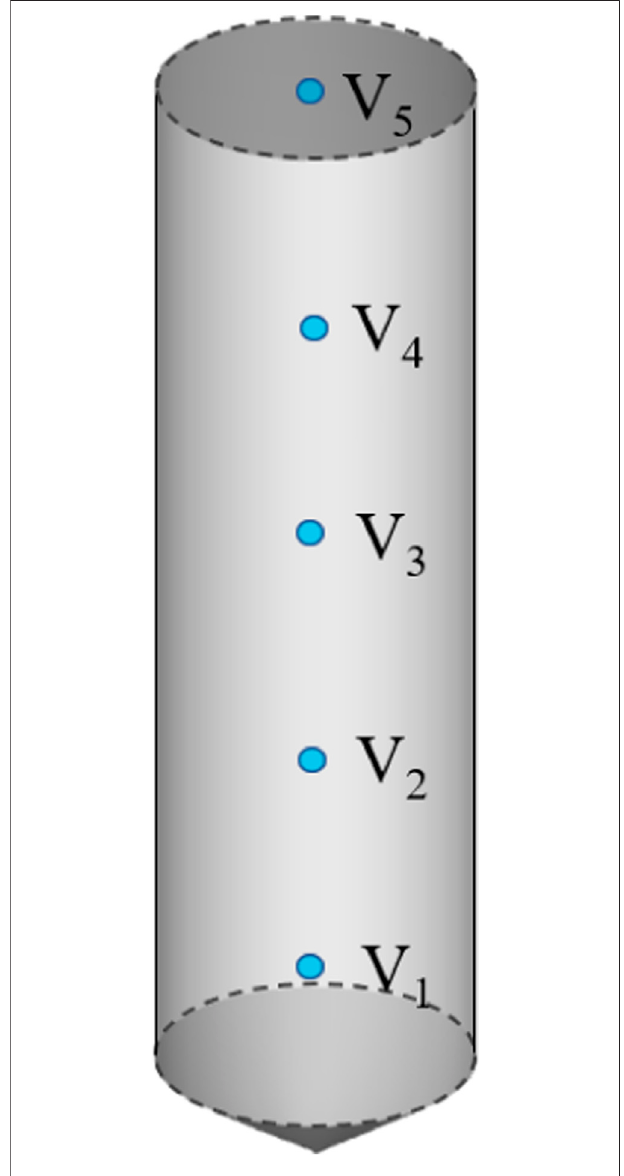
FIGURE 4 | Monitoring points in